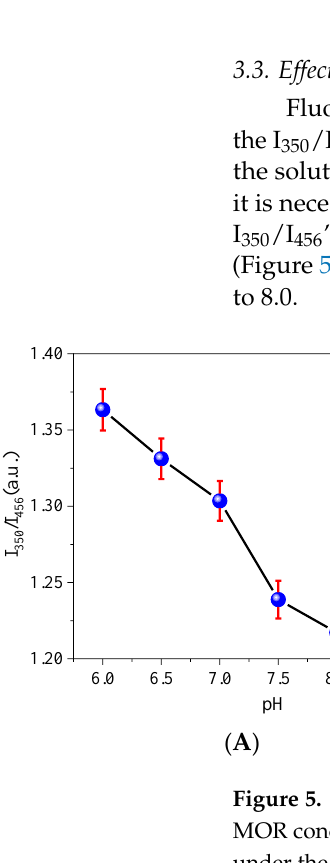
Figure 4. ( A ) UV-Vis absorption spectra of N-CDs; ( B ) fluorescence spectra of N-CDs.